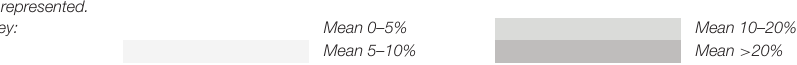
rates for each Symbiodinium strain were generally higher in the presence of low light than in the dark, but this difference was only statistically significant for Symbiodinium CCMP3364 (clade B2), in which the presence of low light stimulated extracellular superoxide production by 50% ( p = 0.04; Table 4 ). On the other hand, Symbiodinium CCMP2466 (clade C1) produced significantly more superoxide in the dark (1183.8 ± 26.1 amol cell − 1 h − 1 ) than in the